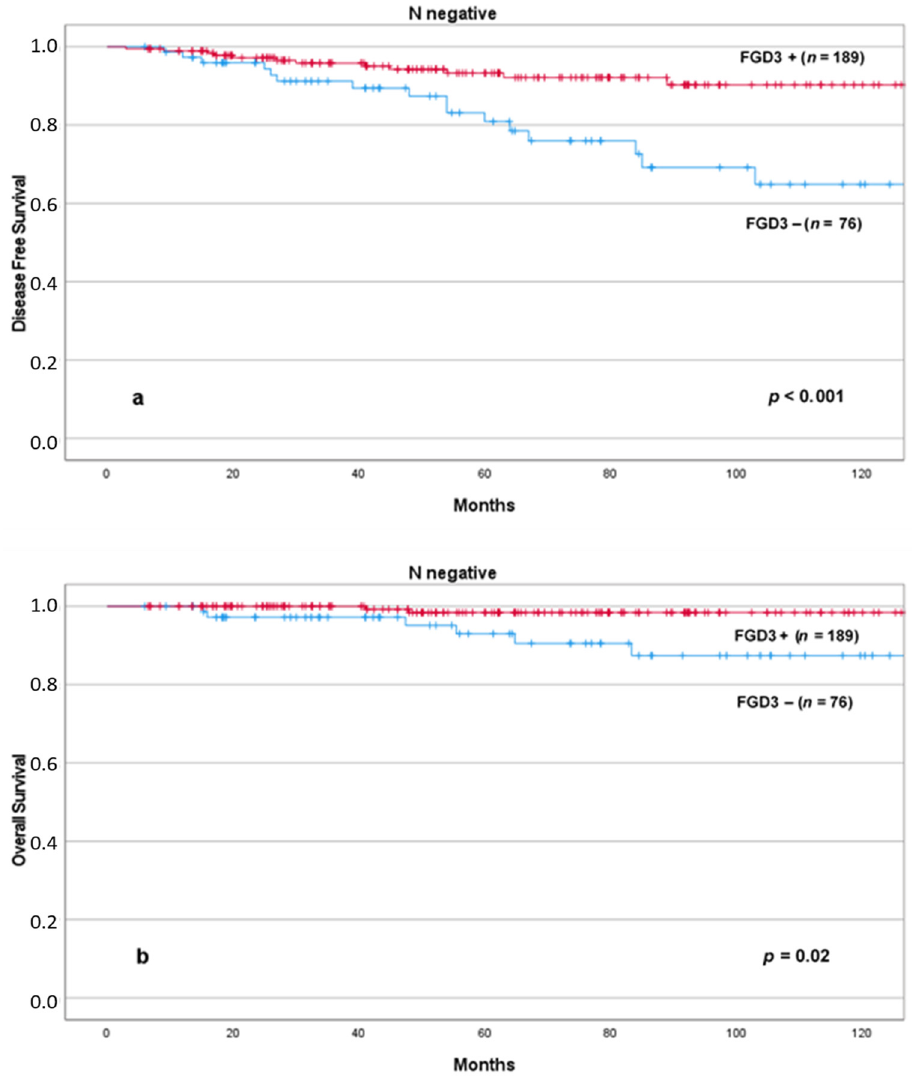
Figure 5. DFS ( a ) and OS ( b ) according to FGD3 expression in node negative patients. Abbreviations: FGD3+: high FGD3 expression; FGD3 − : low FGD3 expression.